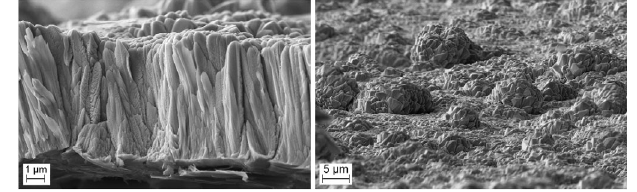
FIG. 6. SEM imaging [37] reveals that Mo coating is not uniform: it has a column-like fine structure (left) and inhomo- geneities up to 10 μ m on its surface (right) that may affect the measured tune shift.